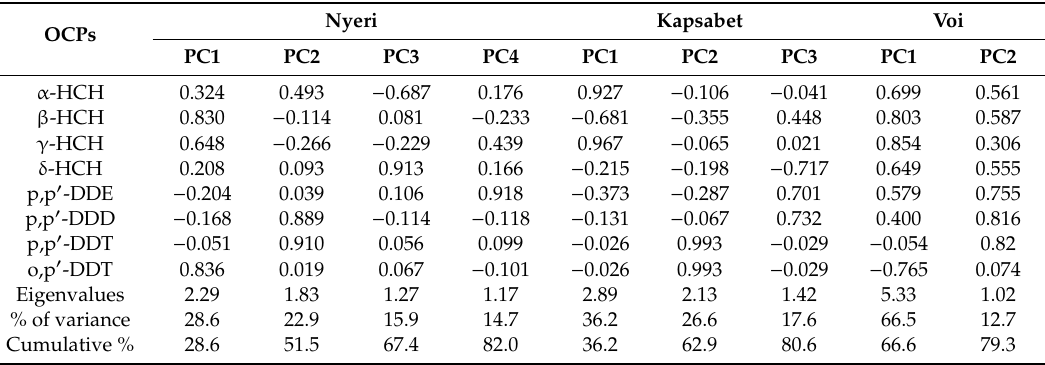
Table 3. Factor loadings for principal rotated component matrix for DDTs and HCHs in Nyeri, Kapsabet, and Voi